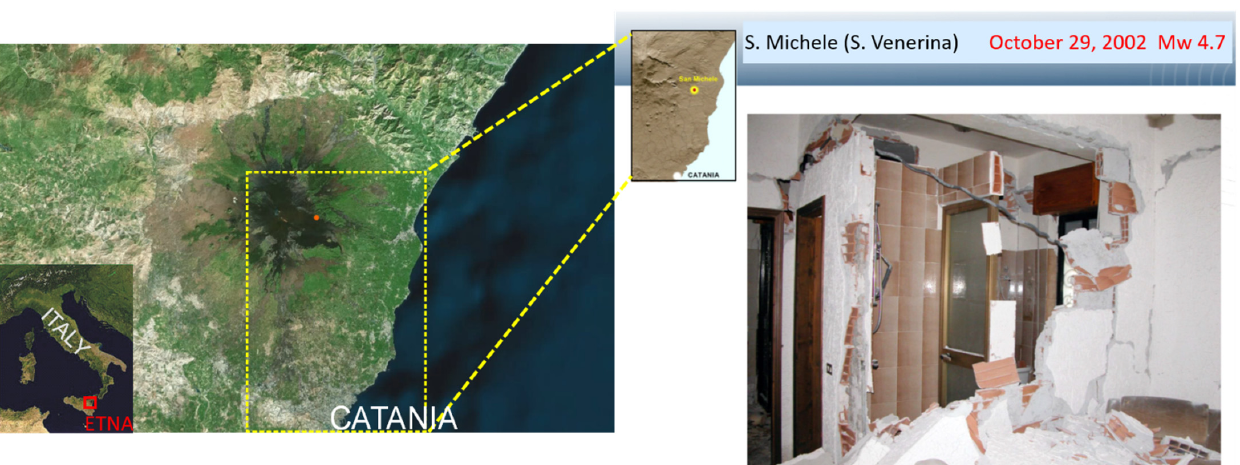
Figure 3. Exploration of a snapshot by AR. The augmented information highlights in red the state of the damage within the buildings at Pescara del Tronto after the earthquakes in central Italy in August 2016 (photo credits: Raffaele Azzaro). The camera of the mobile device tracked each target by means of the object identification system of the AR app. The digital content associated with the target appeared on the tablet or smartphone display and, if opportune, was transferred to a large multimedia monitor.